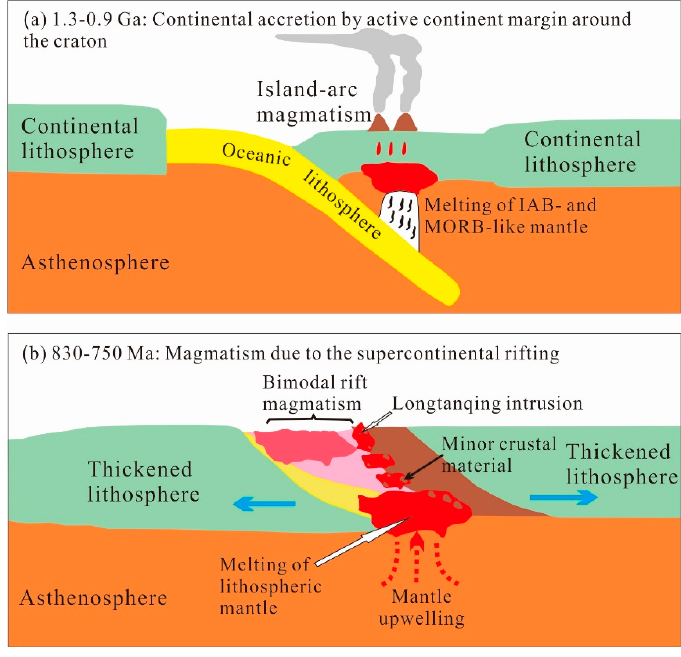
Figure 14. A sketch cartoon showing the tectonic evolution of the western YZB from ca. 1300 Ma to 750 Ma (modified after [12]). Detailed description in the main text.